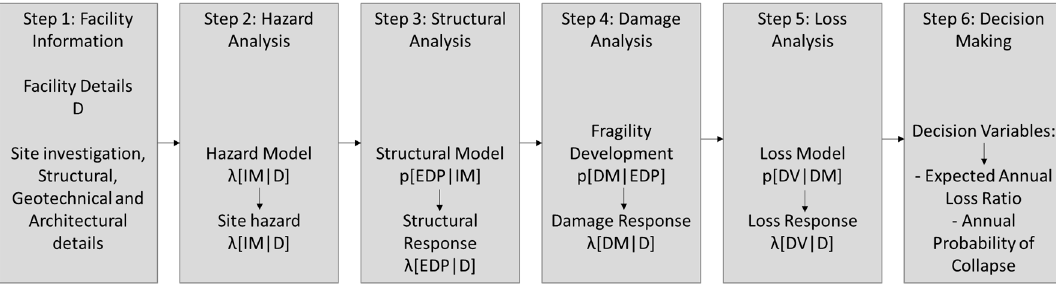
Figure 4. Illustration of the four stages of the PEER PBEE framework (adapted from [27]).